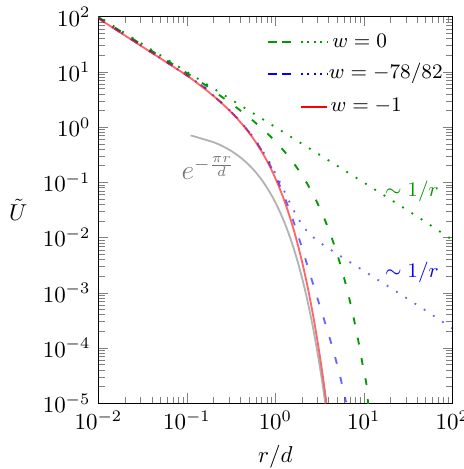
Figure 2. Scaled interaction energy ˜ U = ( 4 π(cid:101) 0 (cid:101) l d / q 1 q 2 ) × U between two point charges q 1 and q 2 as function of the scaled separation r / d according to Equation (4). Different curves corresponds to: w = − 1 (red line); w = 0 and l D → ∞ (green dotted line); w = 0 and l D = d (green dashed line); w = − 78/82 and l D → ∞ (blue dotted line); w = − 78/82 and l D = d (blue dashed line). The gray line shows the approximation ˜ U = e − π r / d of the red line, valid in the limit r (cid:29) d [38]. Note that in all cases the two charges are located in the middle of the dielectric slab, d 1 = d 2 = d